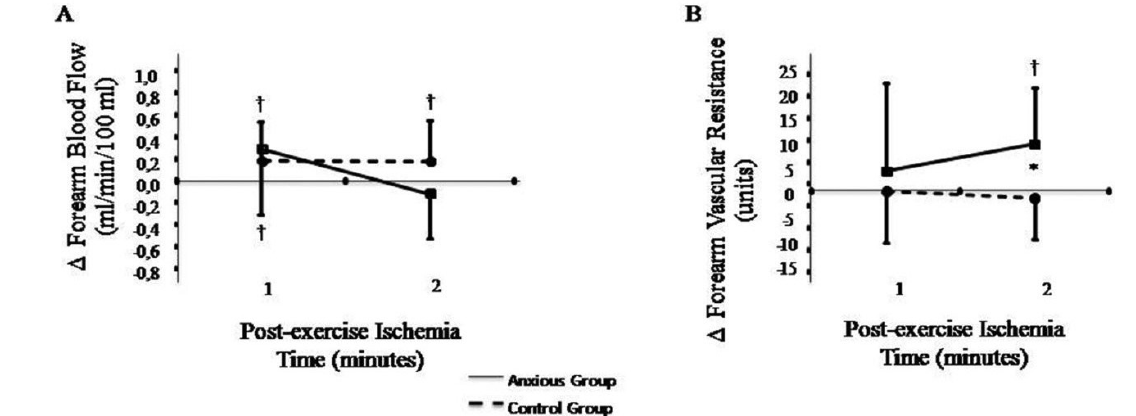
Figure 4. Absolute delta values of the forearm blood flow (ml/min/100 ml) and forearm vascular resistance (units) responses during the post- exercise ischemia protocol. Note that muscle blood flow increased similarly in both groups (panel A), whereas forearm vascular resistance increased in both groups when compared with the resting condition, but the anxious group presented more pronounced increases compared with the control group (panel B). Ip≤0.05 vs. baseline; *p≤0.05 vs.